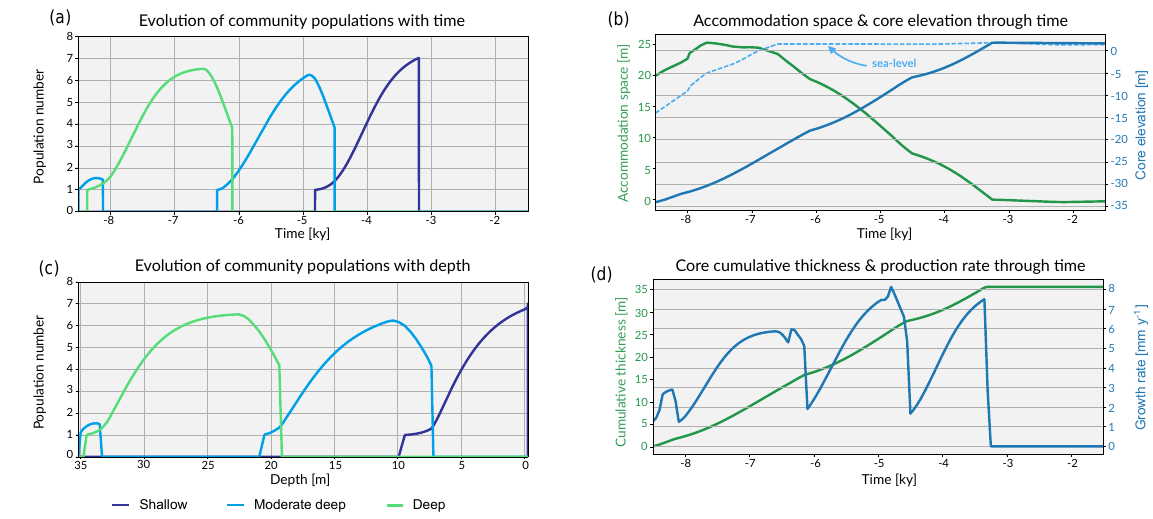
Figure 6. Graphical output from pyReef-Core showing on panels (a, c) the evolution of each community in the form of population number with time and depth. As mentioned previously, population number here is a proxy for carbonate production with larger assemblage population corresponding to faster rate of vertical accretion. Panel (b) shows the evolution of the accommodation space and core elevation through time in relation to imposed sea-level curve. Panel (d) presents the temporal evolution of the cumulative thickness as well as the total coral production rate for the considered